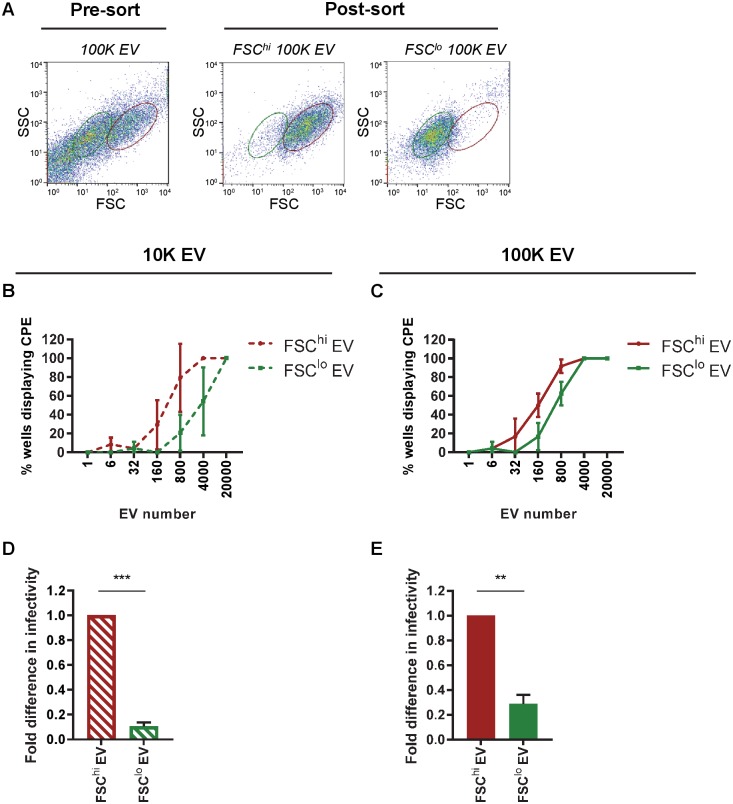
EV subsets distinguished based on light scattering properties differ in potency to transfer virus-infection.10K and 100K EV (1.08 g/ml) from EMCV-infected cells were labeled with PKH67 and analyzed by high-resolution flow cytometry. PKH67-positive EV with different FSC profiles (FSChi and FSClo) were identified and isolated by flow cytometric sorting. (A) Depicted are representative FSC-SSC dot plots of 100K EV before and after sorting of the indicated populations (green = FSClo EV, red = FSChi EV). (B-C): For both 10K (B) and 100K (C) EV populations, the indicated numbers of FSChi EV and FSClo EV were sorted directly onto recipient cells in 96-wells plates, after which wells were screened for occurrence of CPE. Depicted are the percentages of wells displaying CPE upon addition of the indicated numbers of FSChi and FSClo EV. Bar graphs (D,E) show relative differences in infectivity between FSChi and FSClo EV for both 10K (D) and 100K (E) EV, with the infectivity in FSChi EV set to 1. Indicated are mean values ± s.d. for N = 3 independent experiments (** p<0.005, *** p<0.0005).